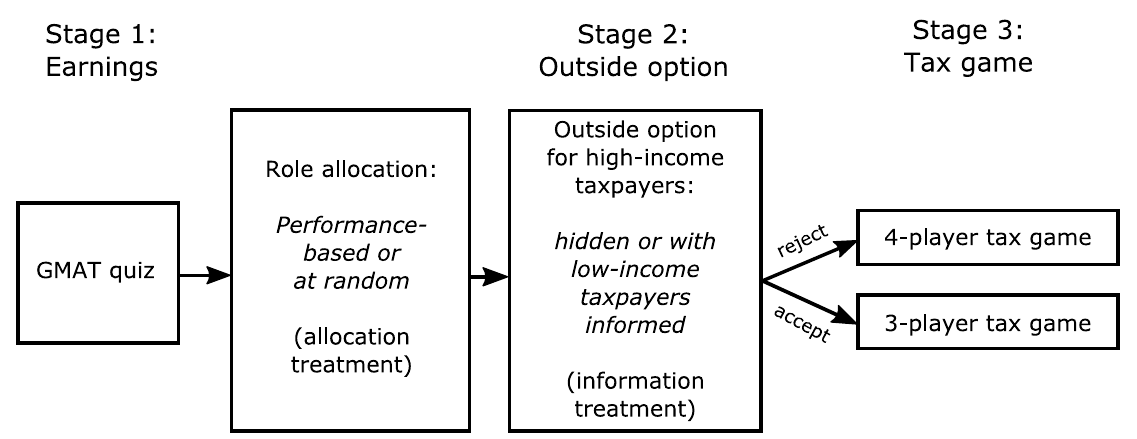
Figure 1. Experimental design